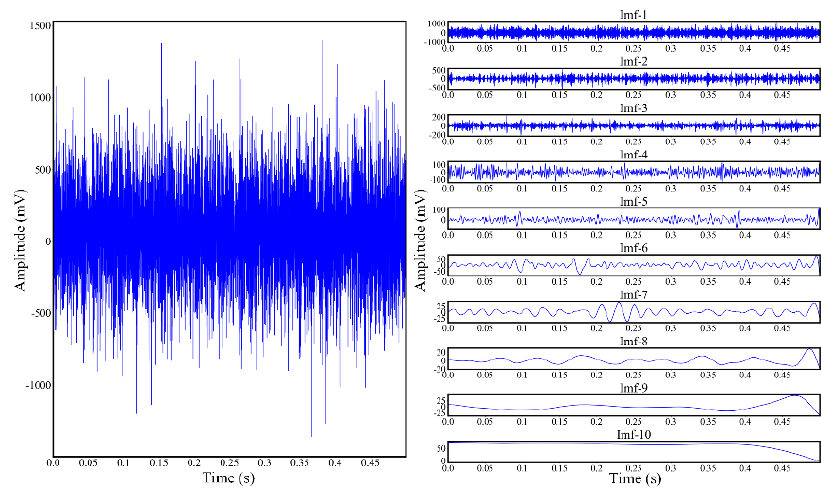
Figure 6. Raw signal and decomposed intrinsic mode functions (Imfs) under the normal mode.